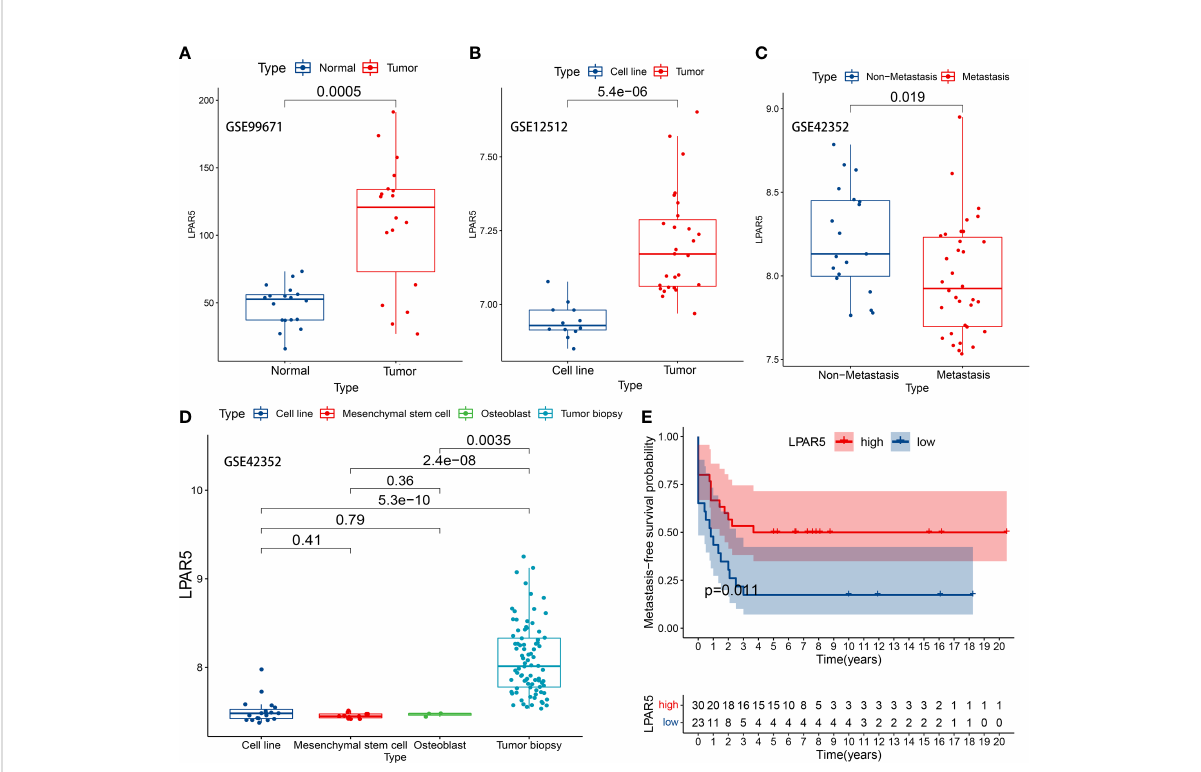
FIGURE 9 LPAR5 expression of osteosarcoma in GEO datasets. (A) LPAR5 expression between tumor tissues and adjacent normal tissues in GSE99671 dataset. (B) LPAR5 expression between tumor tissue and osteosarcoma cell line in GSE12512 dataset. (C) Validation of the difference of LPAR5 expression among osteosarcoma biopsy, osteosarcoma cell line, mesenchymal stem cell and osteoblast by GSE42352 dataset. (D) Validation of the difference of LPAR5 expression between metastasis patients and non-metastasis patients by GSE42352 dataset. (E) Validation of the prognostic value of LPAR5 in osteosarcoma patients by